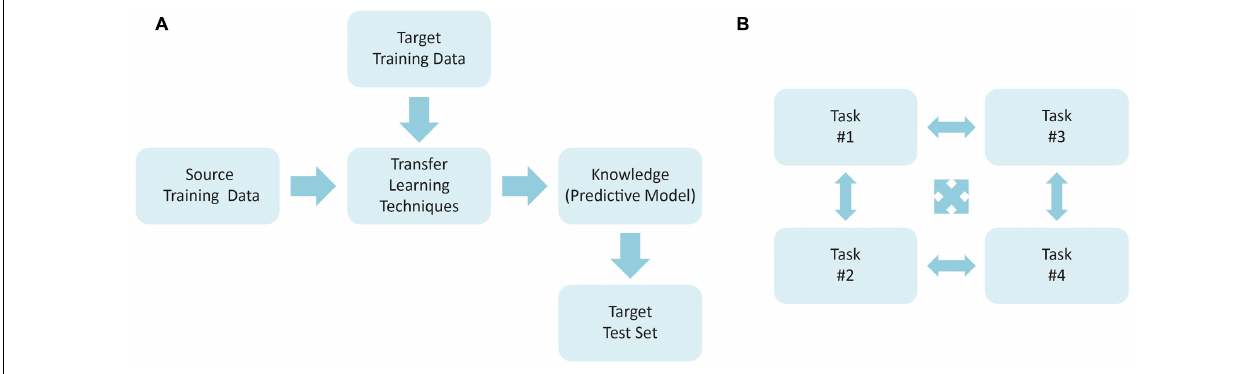
FIGURE 2 | General framework used to plan a study using (A) transfer learning techniques and (B) multi-task learning.